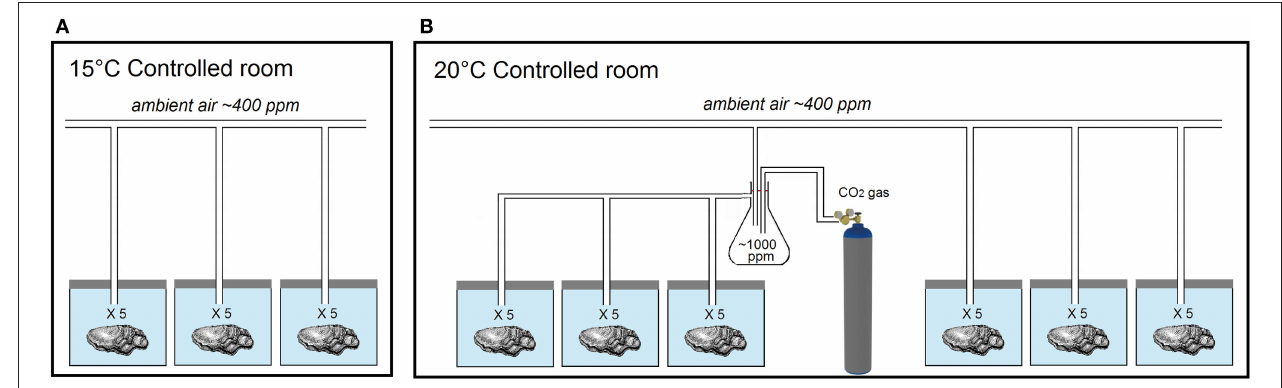
FIGURE 1 | Experimental design used to expose oysters to three acidification and warming treatments. (A) temperature-controlled room kept at 15 ◦ C and holding oysters supplied with ambient air at ∼ 400 ppm. (B) temperature-controlled room kept at 20 ◦ C and holding oysters supplied with ambient air at ∼ 400 ppm and oysters supplied with ∼ 1,000 ppm p CO 2. Each tank contained 5 oysters, one for each of the 5 panelists, such that there were 15 oysters per experimental treatment, and 9 oysters per